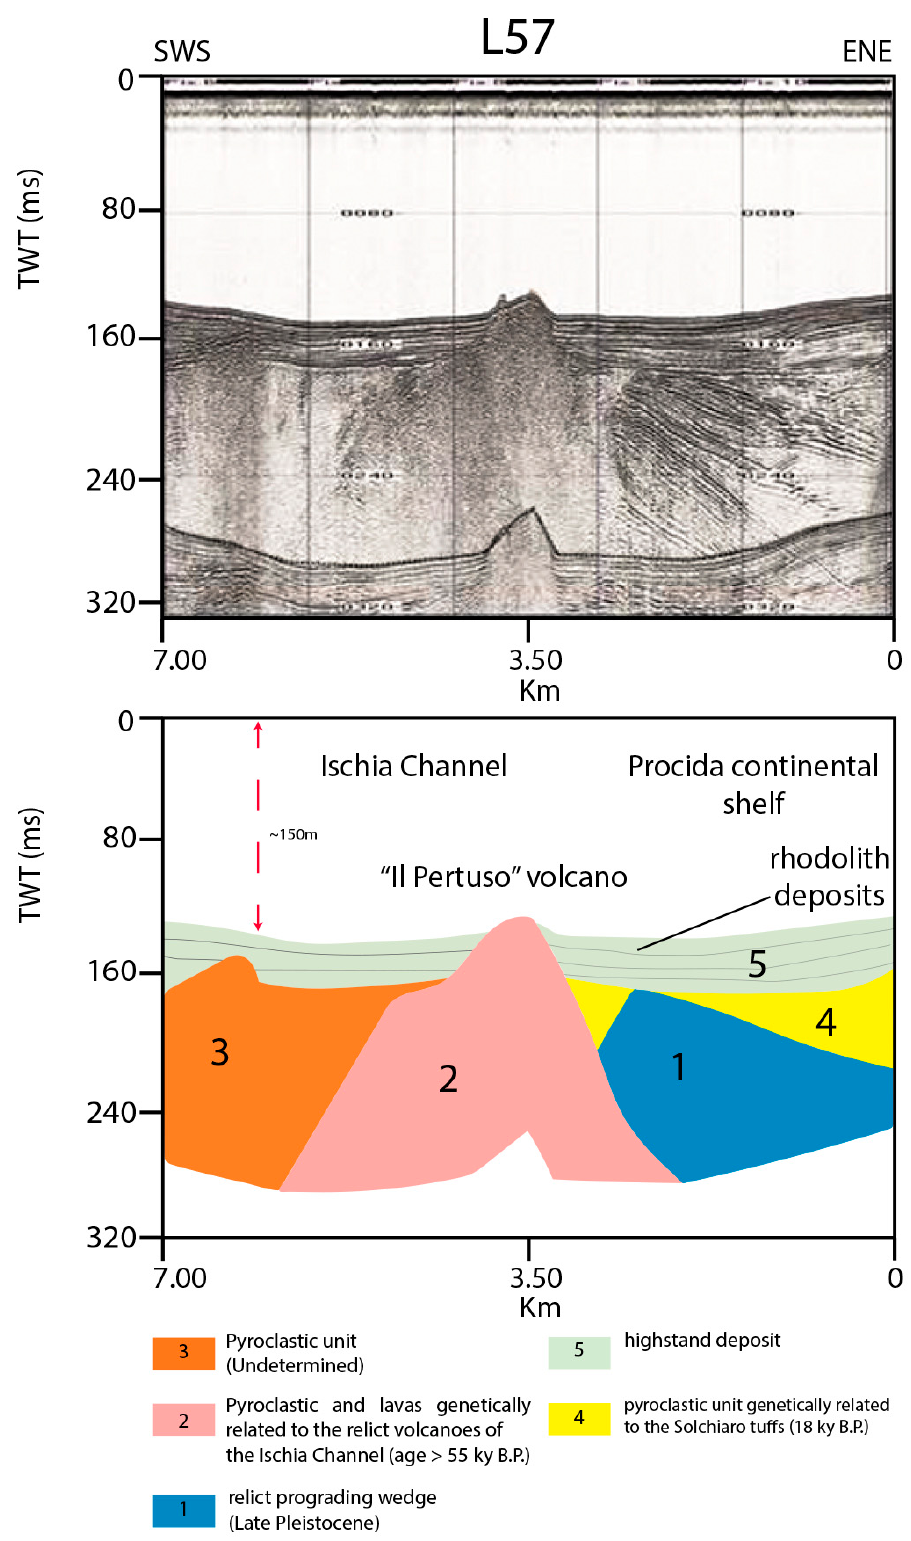
Figure 8. Seismic profile L57 and corresponding geologic interpretation (Ischia Channel). The geologic interpretation of a Sparker line located in the Procida Channel was car- ried out in order to show the stratigraphic architecture of this area (Figure 9). Four main seismic units were recognized based on the geological interpretation. The lowest ones are represented by the pyroclastic sediments deposited before the Campanian Ignimbrite (39 ky B.P.; Figure 9). These units are overlain by the Campanian Ignimbrite (CI in Figure 9). The CI is overlain, in turn, by buried volcanic domes, whose emplacement seems to be